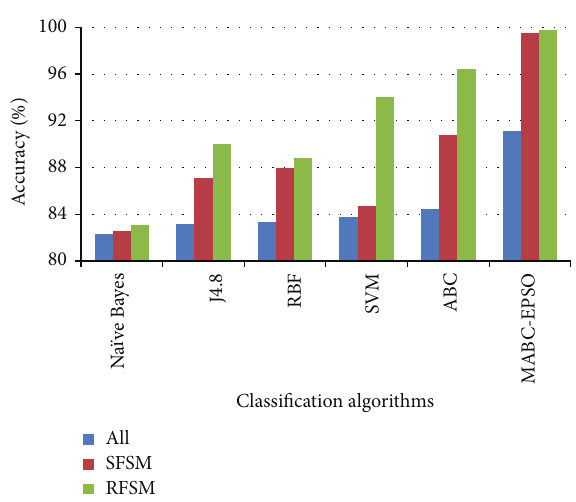
Figure 3: Accuracy comparison of classifiers for DoS